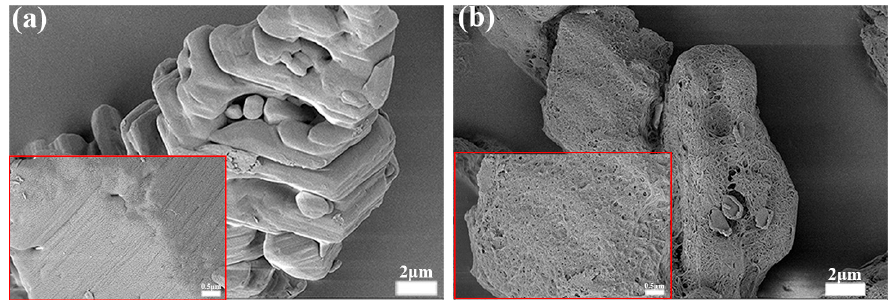
Figure 8. SEM pictures of ( a ) TPPF-0.5 (0.5% PTMEG grafting) and ( b ) TPPF-5 (5% PTMEG grafting) with magnified pictures in the inserts.